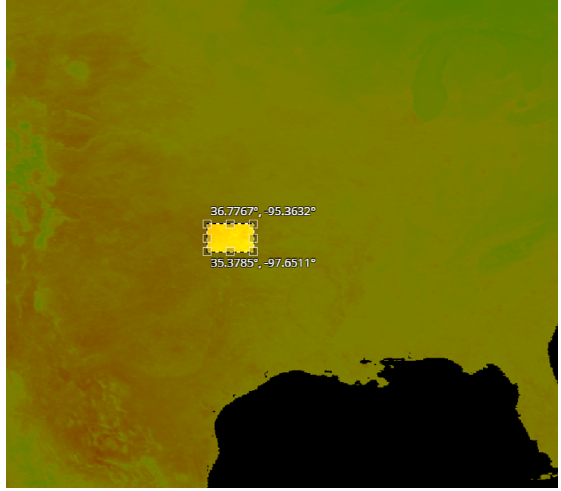
Figure 6. The squares shows the area in Idaho ( top ) and Arkansas ( bottom ) from which we obtained soil moisture values, with resolution of 5 km per